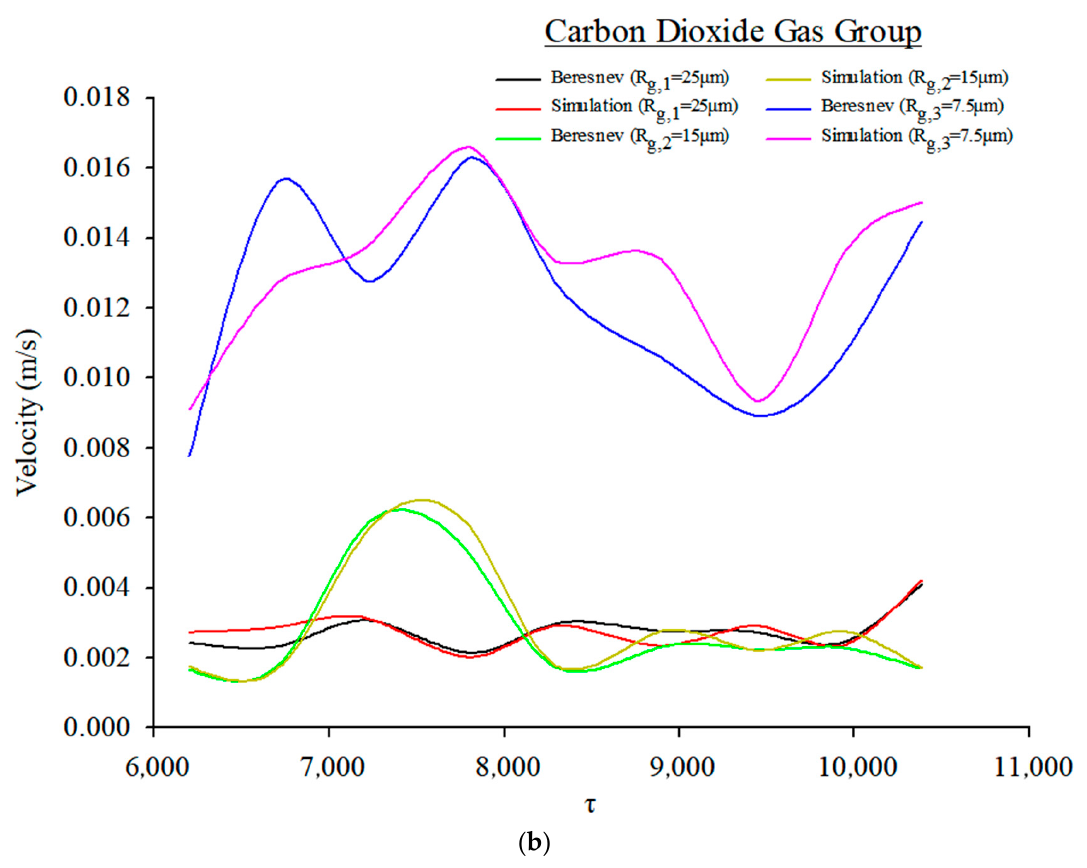
Figure 12. Fluid Velocity Comparison Plot: ( a ) Axisymmetric Pore Throat; ( b ) Continuously Taper- ing Pore Throat.